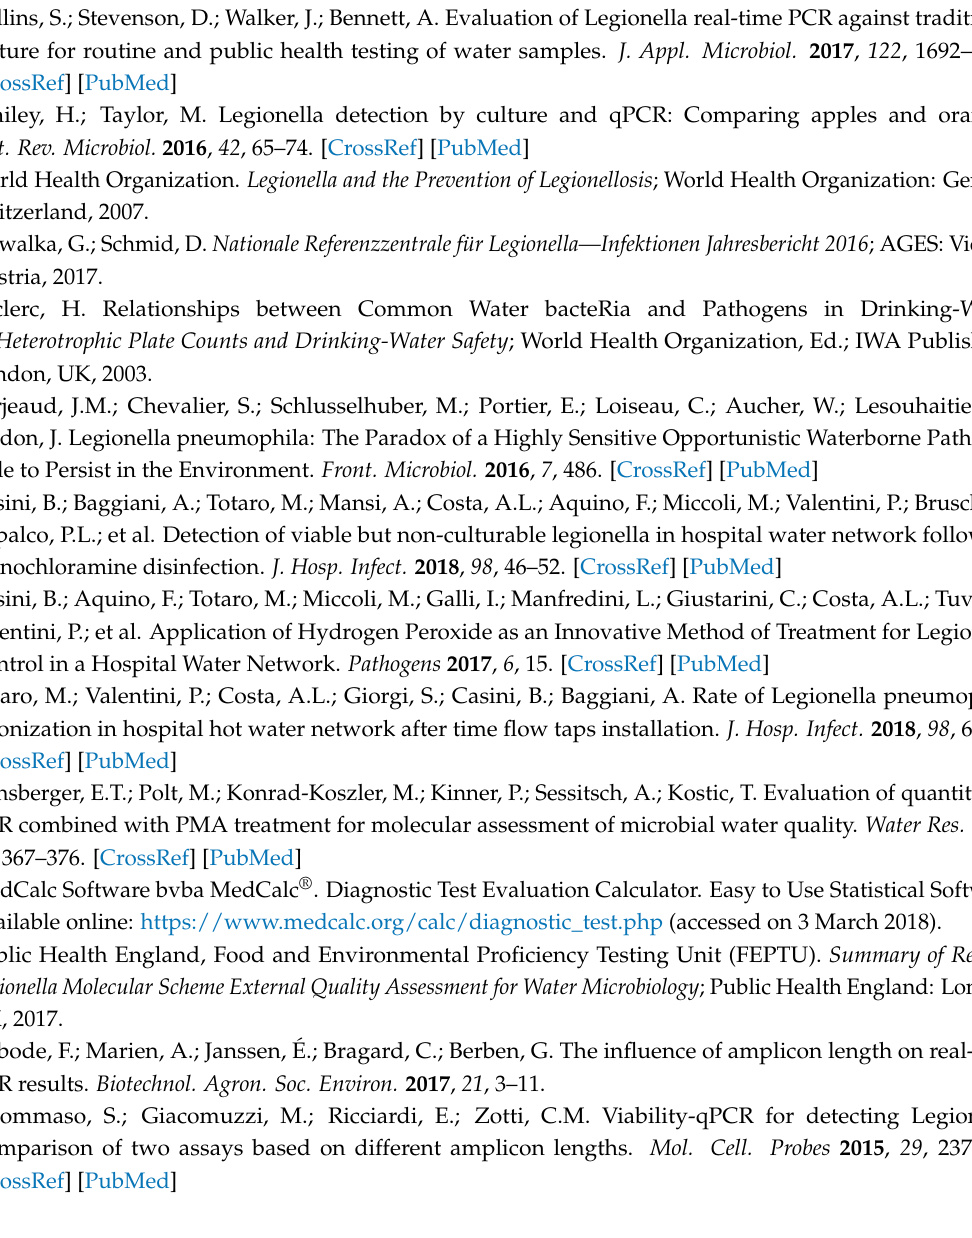
GU/100 mL; Figure S3: Standard curve for wzm -gene based qPCR: serial dilutions ranging from 10 6 to 10 0 target gene copies were used in the qPCR; Figure S4: Linearity of wzm -gene based qPCR: The qPCR shows a LOD of 2 × 10 3 GU/100 mL; Table S1: Results for qPCR and culture for L. pneumophila and L. pneumophila sg1. LOD for qPCR was 2 × 10 2 GU/100 mL for mip ( L. pneumophila ) and 2 × 10 3 GU/100 mL for wzm ( L. pneumophila sg1 ), values below LOD were set to zero. LOD for culture was 1/100